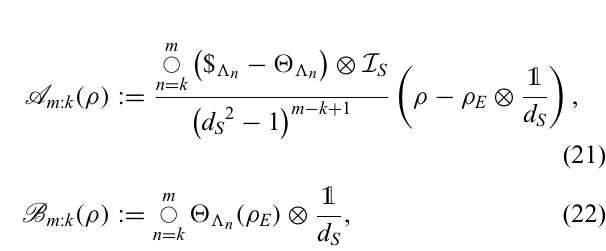
FIG. 3. Determining time scales of finite non-Markovian noise. A noise process with initial finite non-Markovian noise over a sequence length (cid:10) = 5 will decay as described by a Markovian ASF after such a step, with the non-Markovian part contributing as SPAM error factors. By fixing to identity the gates of at least time steps, steps 2 and 3, the decay of the ASF corresponding to such a sequence becomes entirely Markovian; this allows us to operationally determine the time scales of finite non-Markovian noise as well as to construct sensible Marko- vian ASFs to quantify RB non-Markovianity, as exemplified in Sec.